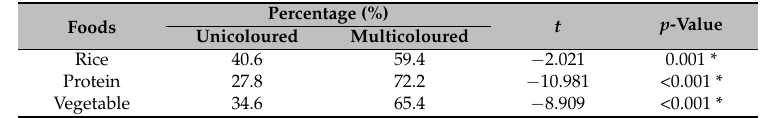
Table 9. Comparison of meal energy based on plate size between genders ( n = 133). Meal Energy Mean ± SD (kcal) Food Type 23-cm Plate 28-cm Plate